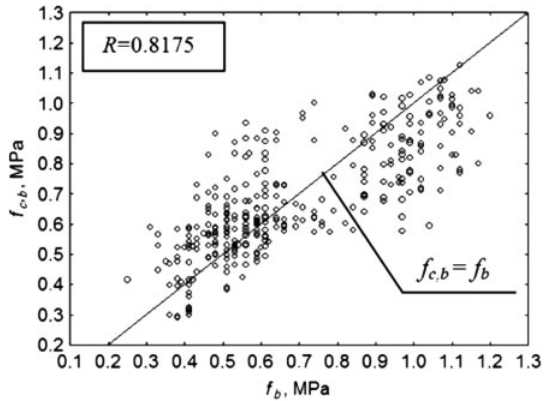
Fig. 13. Dependence between experimentally determined pull-off adhesion f b and pull-off adhesion f c , b identified by neural network during its training